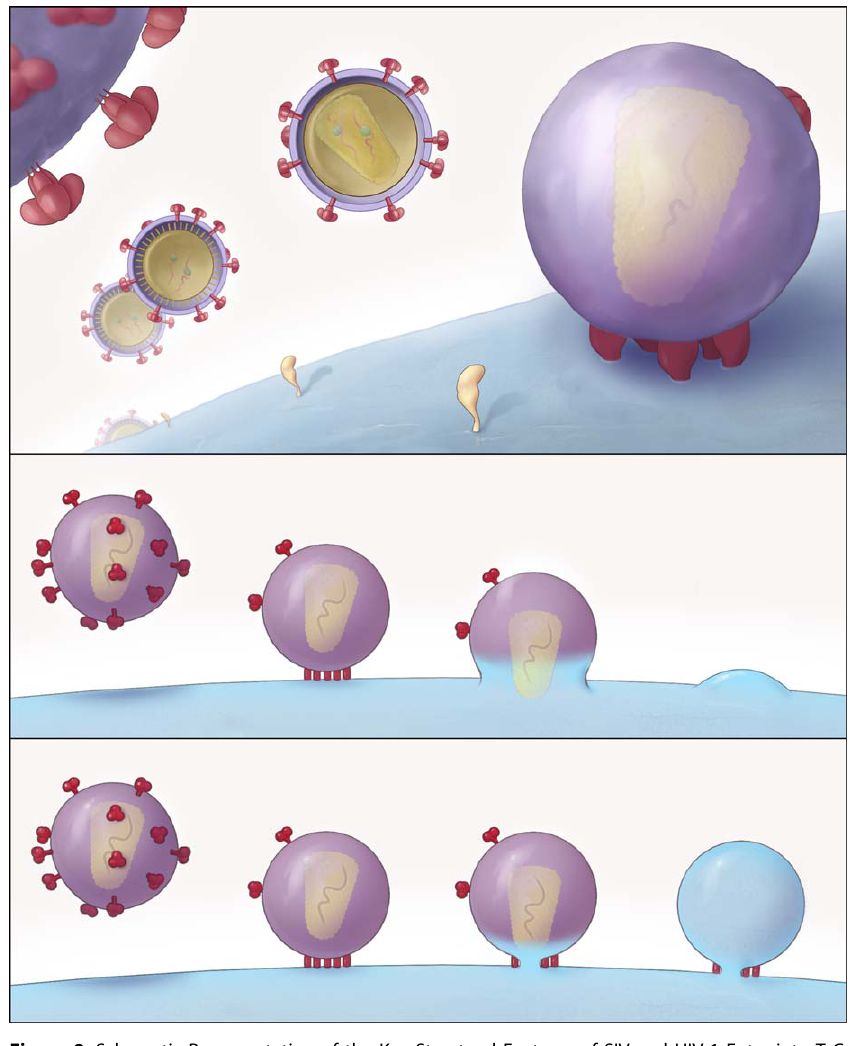
Figure 8. Schematic Representation of the Key Structural Features of SIV and HIV-1 Entry into T Cells (A) Different stages of viral entry from budding, to maturation, to entry claw formation. For the SIV strain used here, viruses that are docked to the cell via an entry claw show very few, if any, viral spikes on their surface, whereas non-contacting viruses typically display between 60 and 100 spikes on their surface. The entry claw is composed of between five to seven anchors spanning the region between the virus and the cell, each ; 100 A˚ long, and spaced laterally by ; 150 A˚. (B and C) Two alternative models for viral entry. In the global fusion model (B), the formation of the entry claw is followed by progressive fusion of the viral membrane across its width, leading to merger of the contents of the viral membrane with the cellular membrane. In the local fusion model (C), the formation of the entry claw is followed by the creation of a local pore centered at one of the rods, leading to delivery of the viral core into the cell.